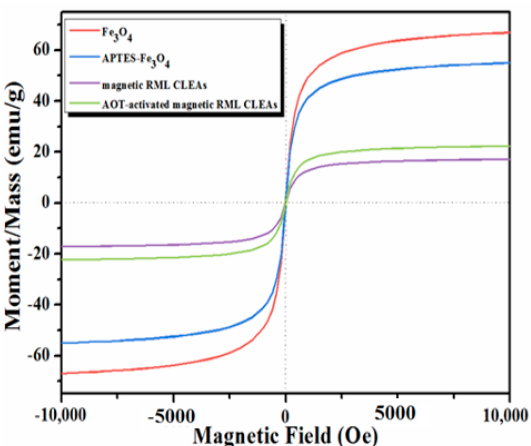
Figure 5. Magnetic hysteresis loops of Fe 3 O 4 nanoparticles, APTES-functionalized Fe 3 O 4 nanoparticles, magnetic RML CLEAs and AOT-activated magnetic RML CLEAs.